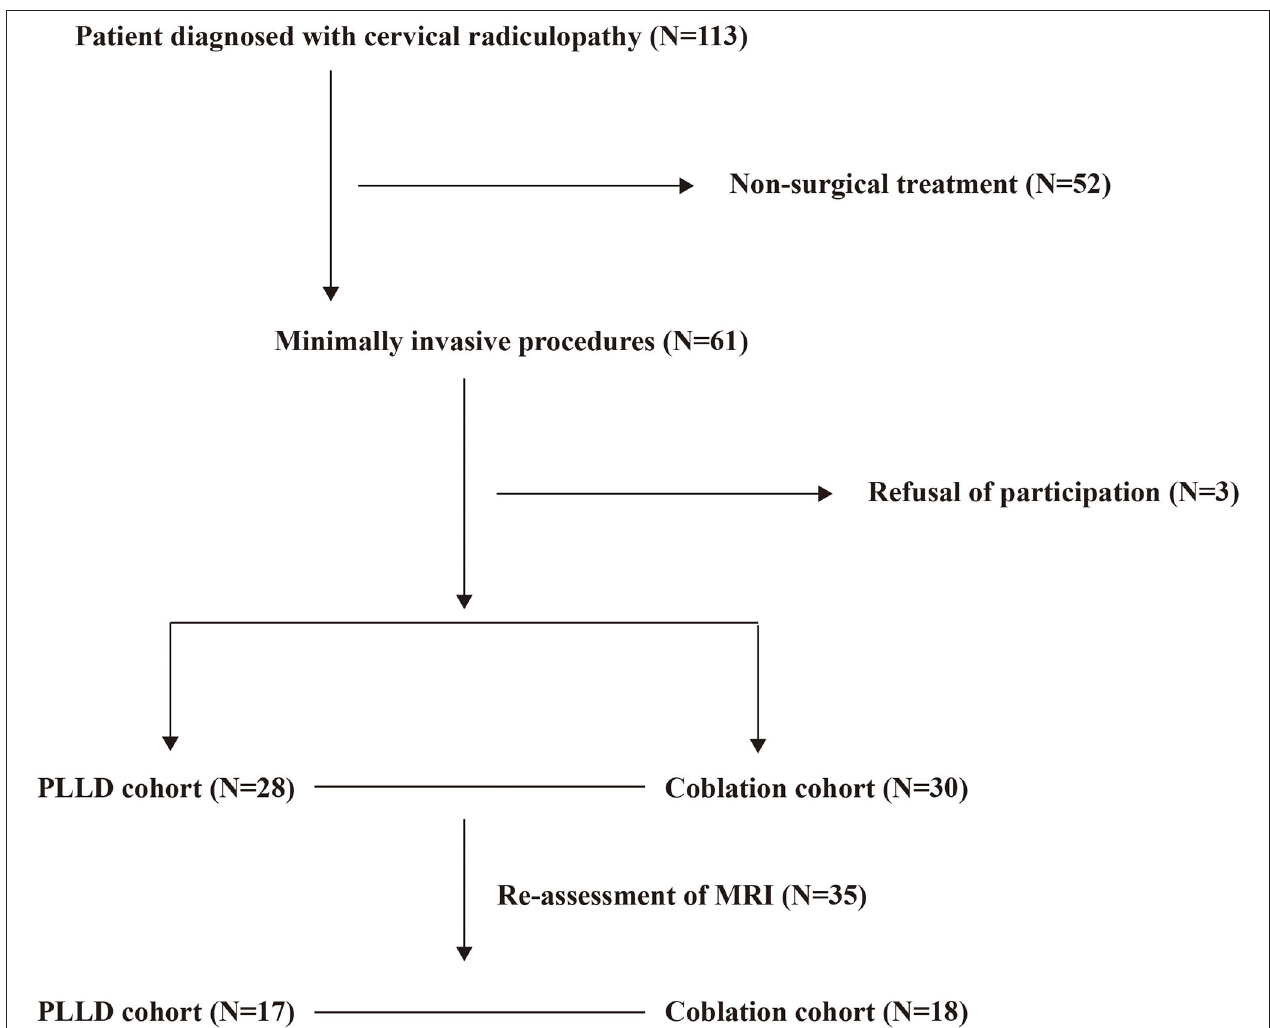
FIGURE 1 | The flow chart of patient